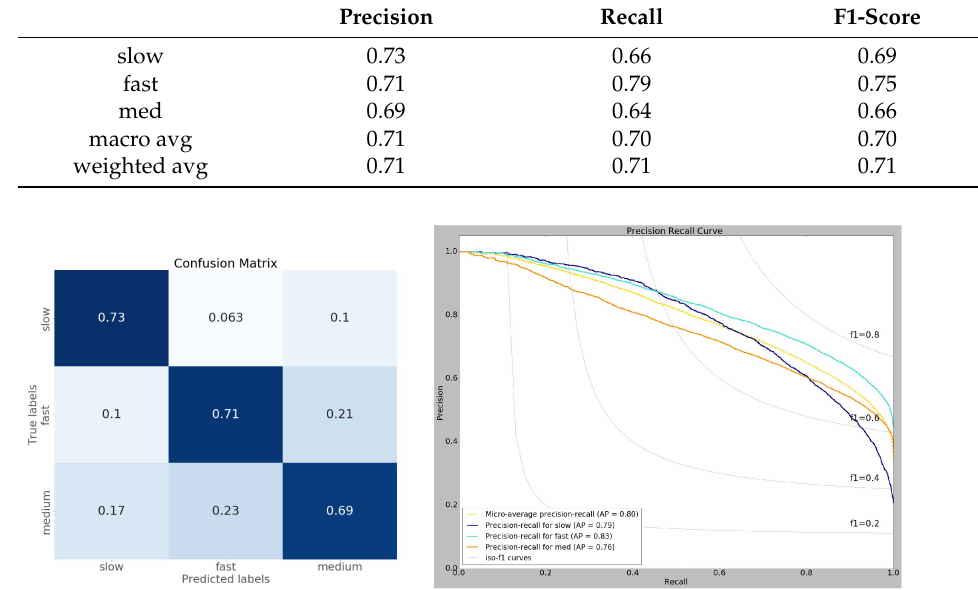
Figure 6. ( Left ) Normalized confusion matrix of model predicted RTs. The model makes more confusion between medium RTs with slow and fast RTs. The model also confuses some fast RTs as medium RTs. ( Right ) Precision-Recall curve of the model prediction. The model learned the spatial-spectral patterns of fast RTs (AP = 0.83) efficiently followed by slow (AP = 0.79) and medium RTs (AP = 0.76). The fast RTs are also the most stable as indicated by the f1 score (>0.6) under extreme thresholds. The increased model performance on fast RTs might be due to having the majority of samples and low uncertainty (42% of the training